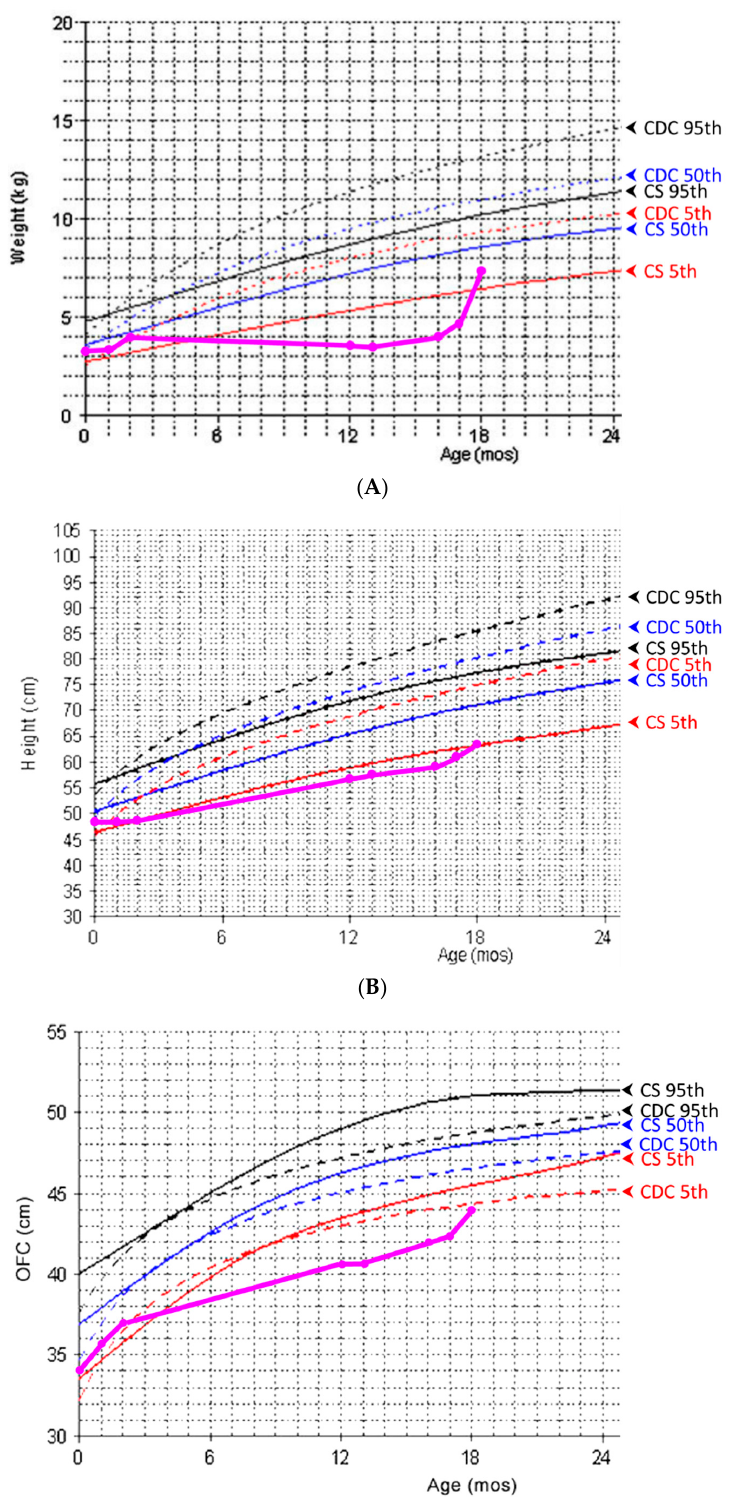
Figure 1. The patient’s serial body weight ( A ), length ( B ), and OFC ( C ) measurements (in pink) compared to the normative growth chart of normal individuals and CS patients. Adapted with permission from Ref. [3]. 2012, Karen W. Gripp. OFC, occipitofrontal head circumference; CDC: Centers for Disease Control and Prevention; CS: Costello